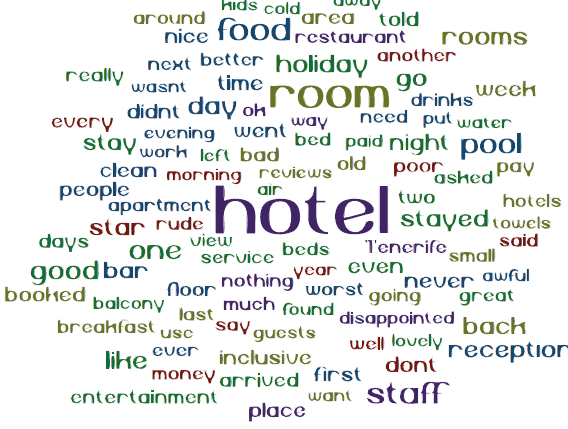
Figure 1: Negative review words.